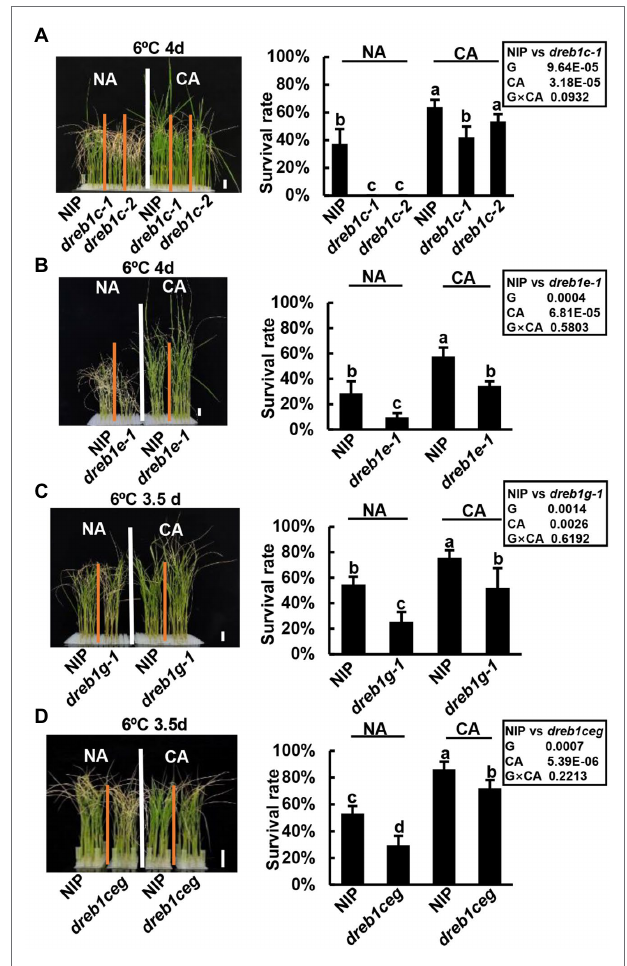
FIGURE 4 | OsDREB1C / E / G genes do not affect cold acclimation in rice. Growth phenotypes and survival rates of dreb1c (A) , dreb1e (B) , dreb1g (C) , and dreb1ceg (D) after chilling treatment and recovery growth with cold acclimation (CA) and without cold acclimation (NA). Seedlings were hydroponically grown at 28 ° C for 3 weeks till three-leaf stage, treated 1 day at 12 ° C (CA) or 1 day at 28 ° C (NA), before treated at 6 ° C for 3.5 or 4 days followed by a recovery growth at 28 ° C for 7 days. Left panels show plant morphology after recovery. Bars in plant images represent 2 cm. Right panels show survival rates expressed as mean ± SD from three biological replicates each with 24 seedlings. Lowercase letters above the bars indicate significant differences among samples at p < 0.05, by SSR test. Insert shows multiway- ANOVA analysis of genotype (NIP versus dreb1 mutants) and cold acclimation (NA versus